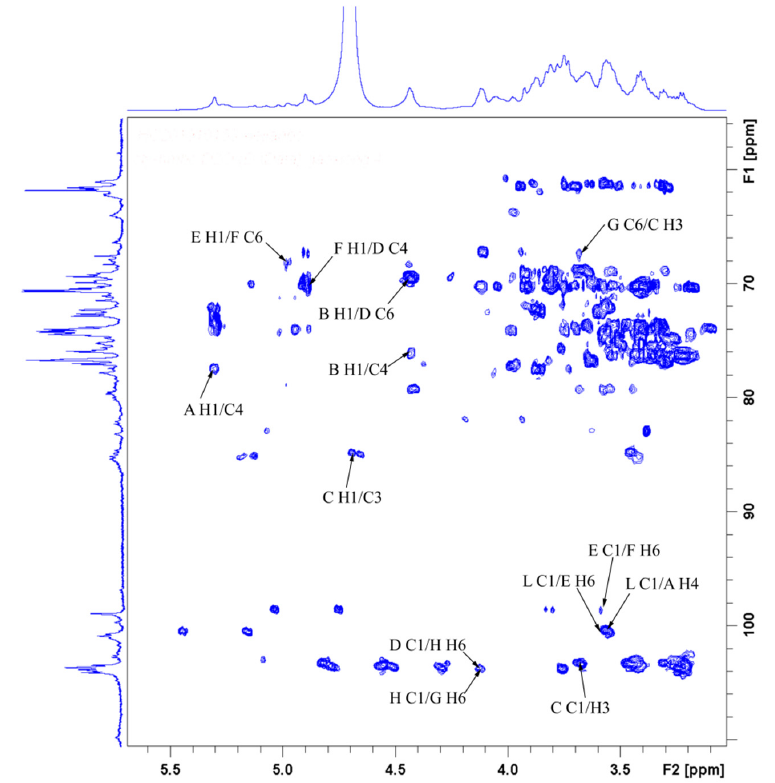
Figure 11. HMBC spectrum of GLP-1.